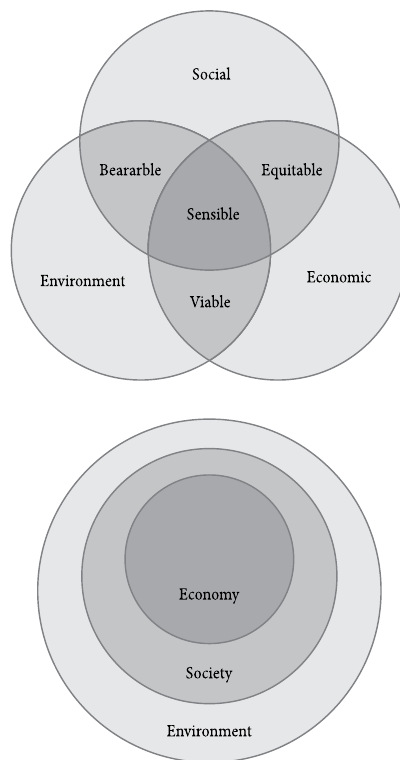
Fig. 1. Intersected and nested models of the three dimensions of